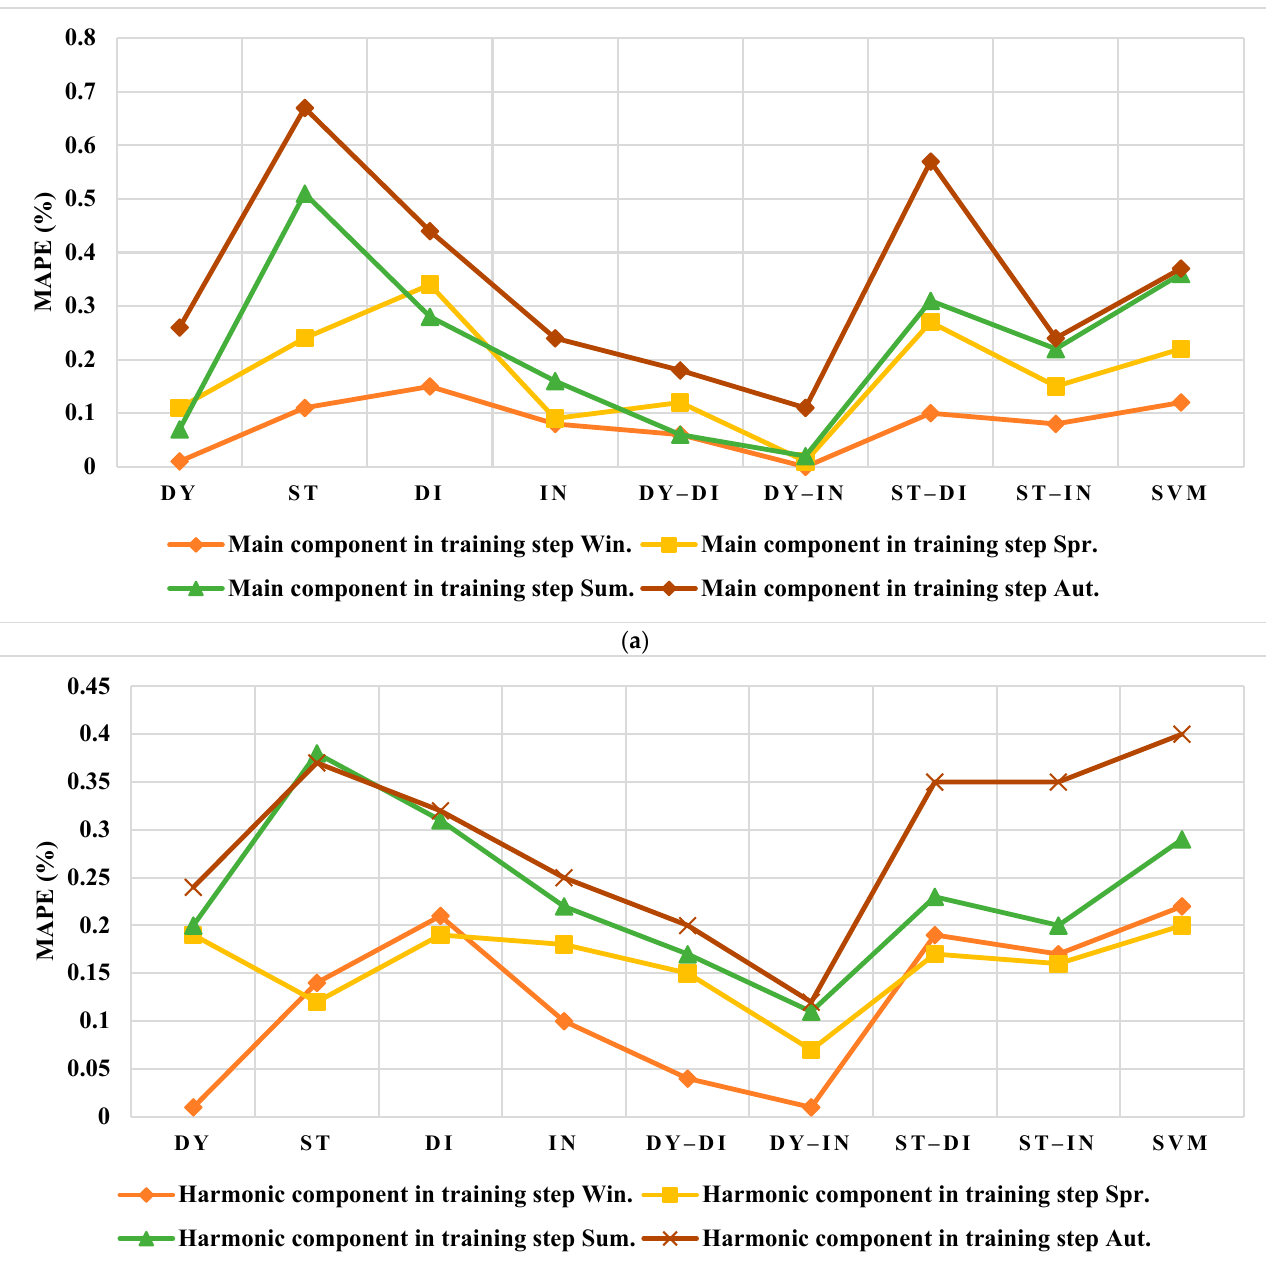
Harmonic component in training step Spr. Harmonic component in training step Aut.